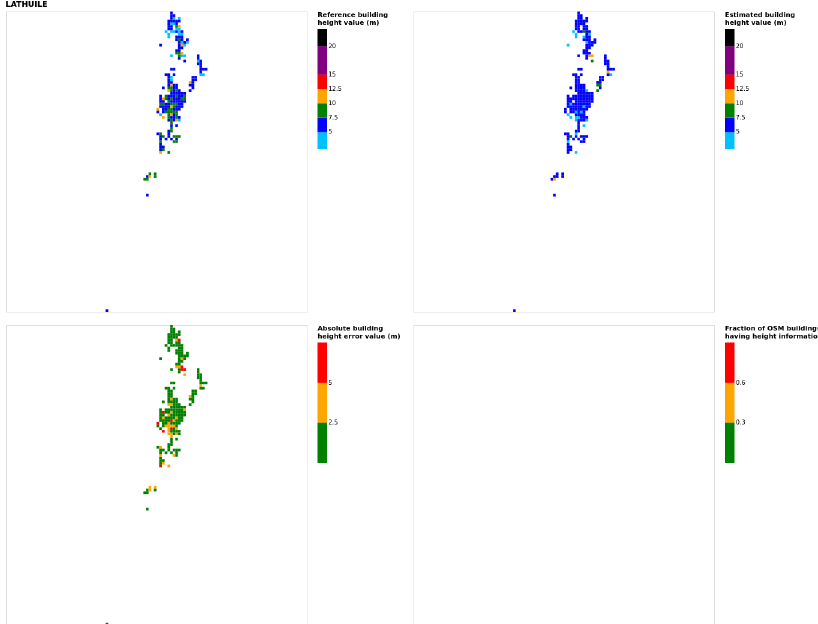
Figure B11. Results for the commune at grid cell (upper left panel) reference building height, (upper right panel) estimated building height, (lower left panel) absolute building height error, and (lower right panel) fraction of OSM buildings that have height information. For all panels except the lower right, only cells that have buildings – with at least 90% of their buildings having no height value in OSM – are displayed.